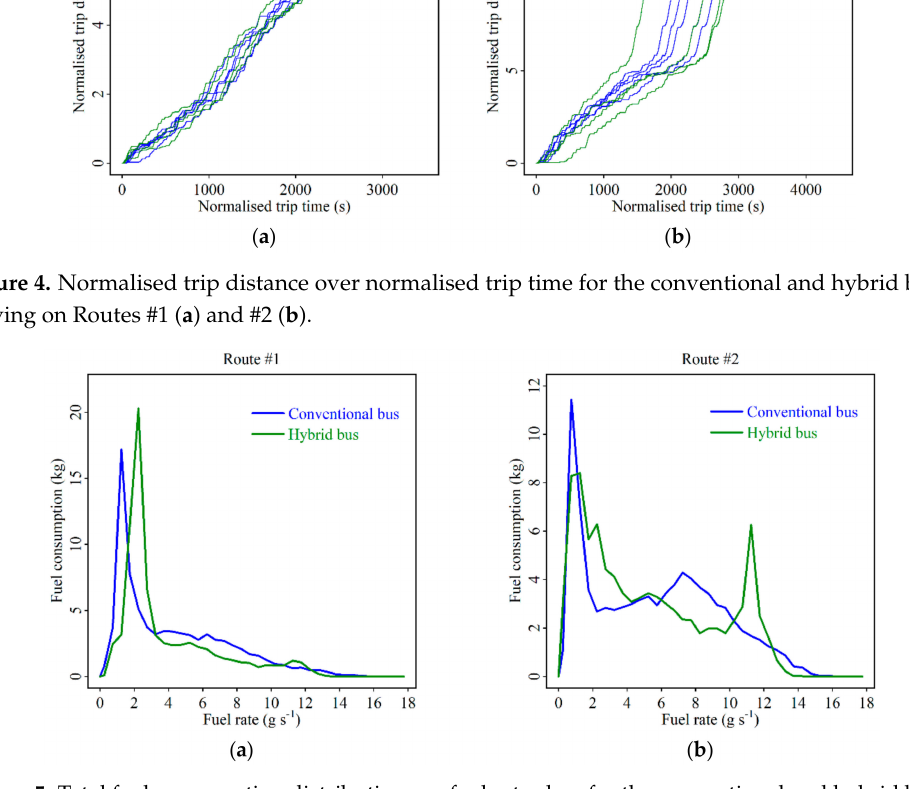
Figure 5. Total fuel consumption distribution per fuel rate class for the conventional and hybrid buses. ( a ) Route #1, ( b ) Route